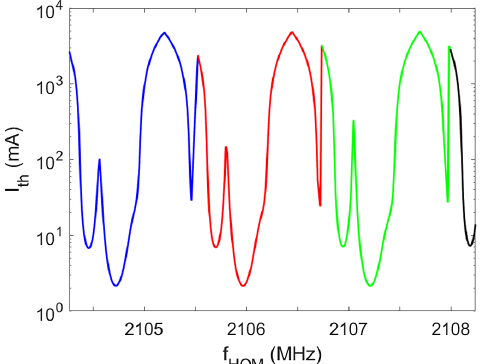
FIG. 6. Threshold current periodicity over HOM frequency. Different period colored differently. The filling pattern used is f 1 2 3 4 5 6 g and the phase advance μ ¼ 1 . 5 π .